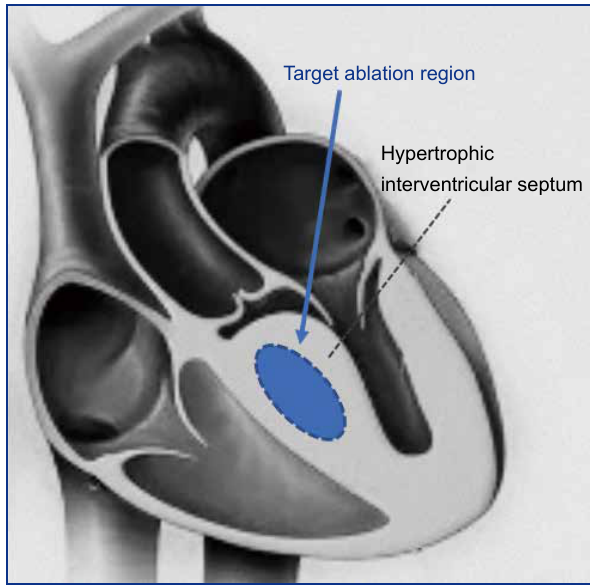
Figure 1 Illustration of the target area for ablation of the interventricular septum.